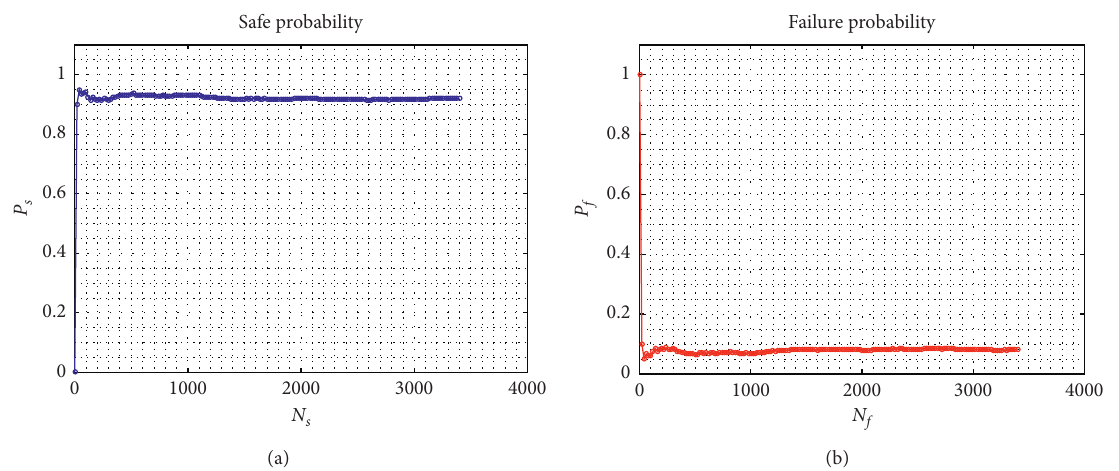
Figure 12: Convergence of the safe probability of the 20-year corroded SCC